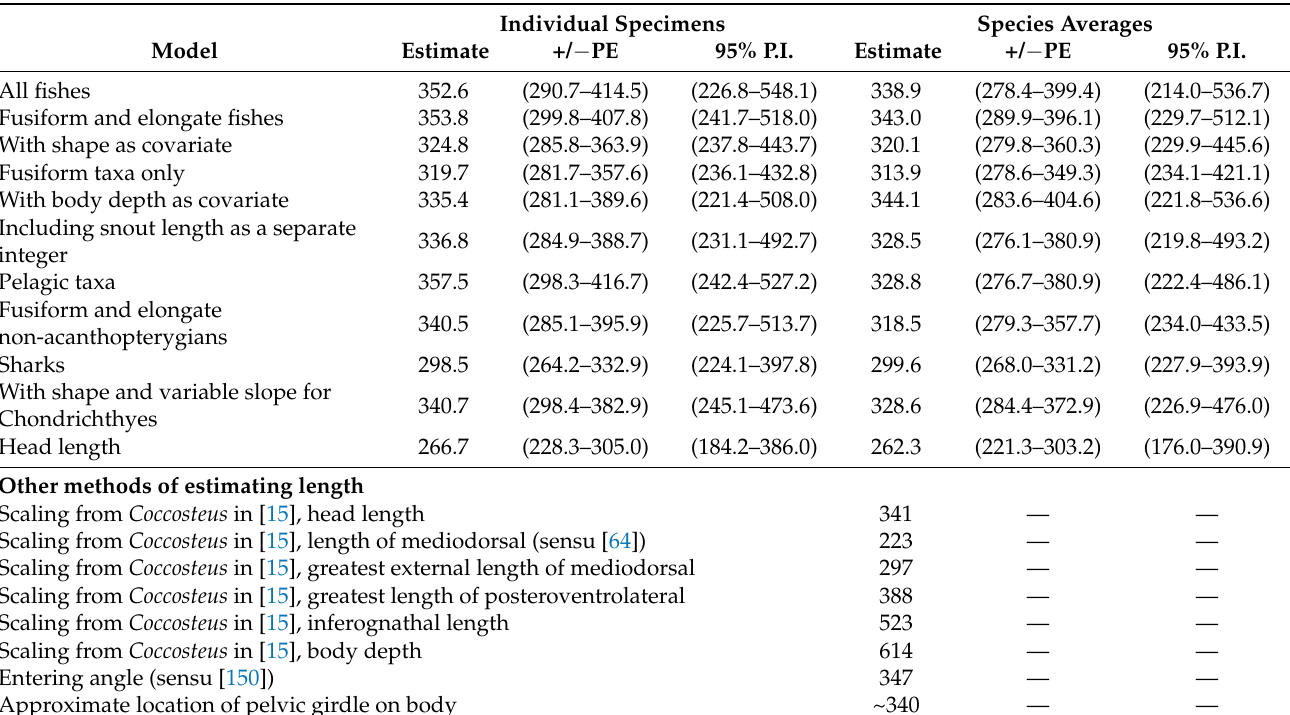
Table 3. Length estimates of the largest complete individual of Dunkleosteus terrelli (CMNH 5768) under a variety of different models and starting assumptions. Abbreviations as in Table 2. All measurements in